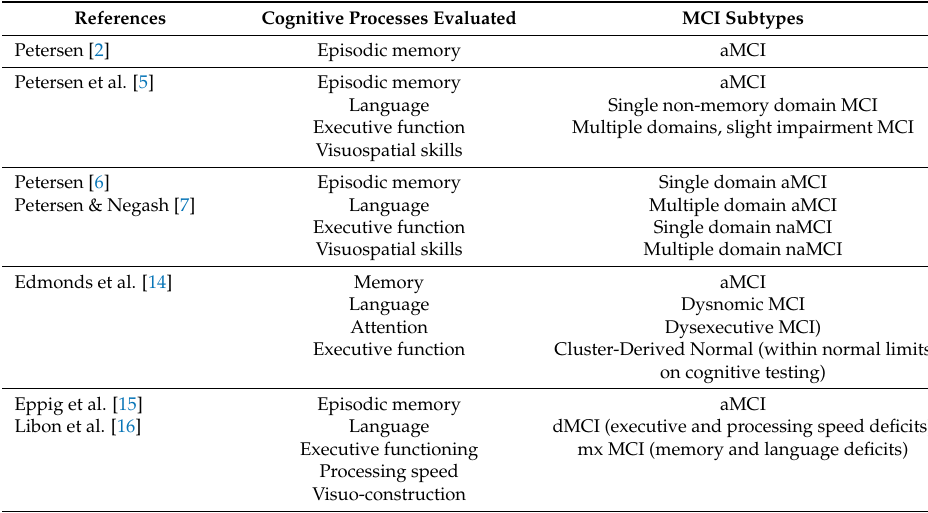
Table 1. Sub-classification of the different MCI